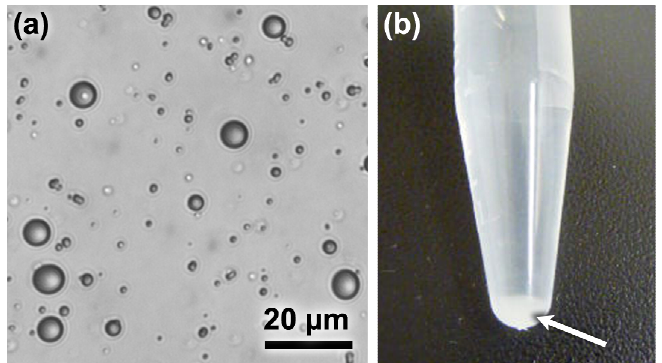
(pAA)/poly(allylamine hydrochloride) (pAH) ratio at pH 6.5. Complexes were prepared